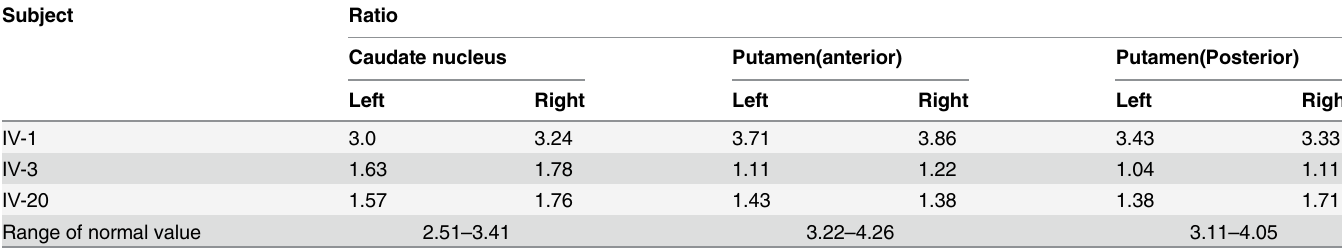
Table 2. Quantitative comparison of 11 C-CFT uptake in the family members.